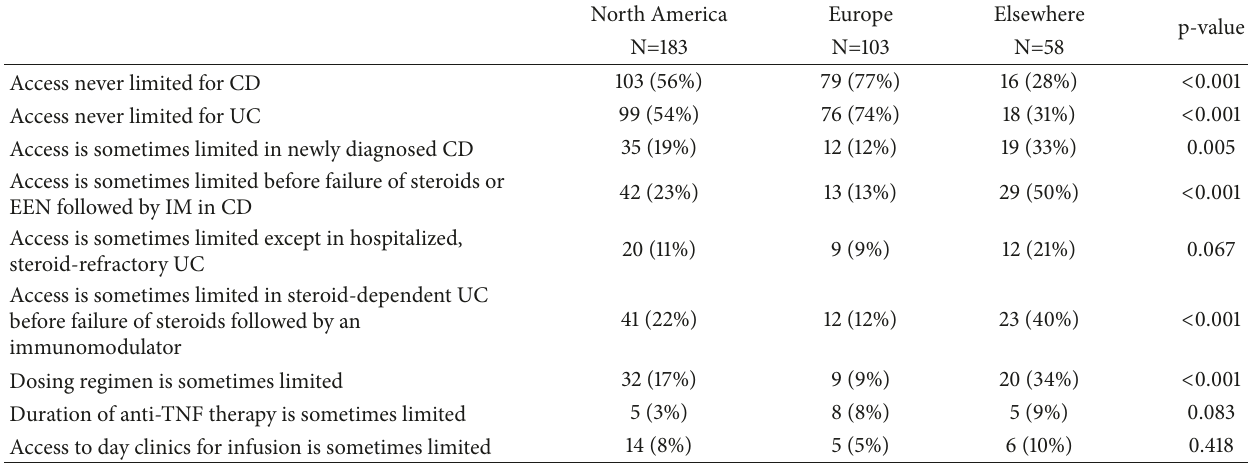
Table 4: Access limitations identified by respondents. Results are presented as N